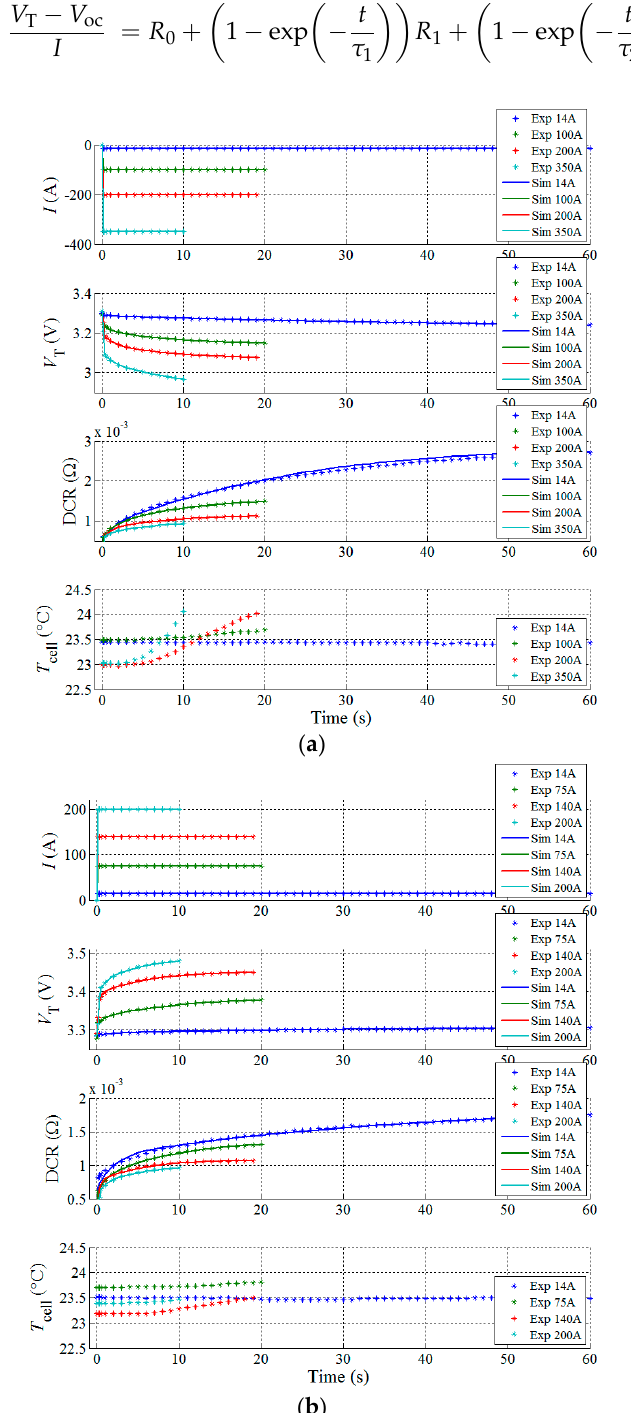
Figure 4. Pulses tested at ( a ) 4 discharge currents and ( b ) 4 charge currents at 50% SOC. Dots represent experimental data and the curves represent simulation. The root-mean-square (RMS) errors between simulated and experimental voltage are below 1.5 mV, showing good fitting quality.